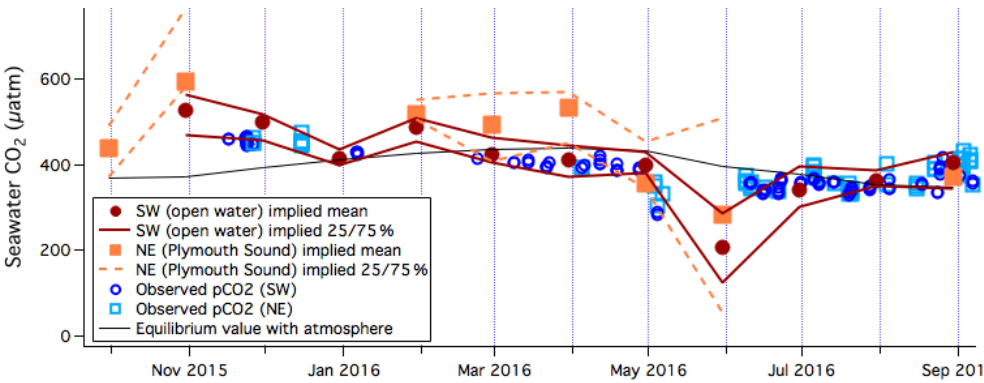
Figure 7. Monthly averages and 25th and 75th percentiles of implied seawater p CO 2 for the southwest (open water) and northeast (Plymouth Sound) wind sectors. Observed p CO 2 from the Plymouth Quest within the southwest sector (plus at L4) and within the northeast sector are also shown, along with the equilibrium value with respect to the atmosphere.